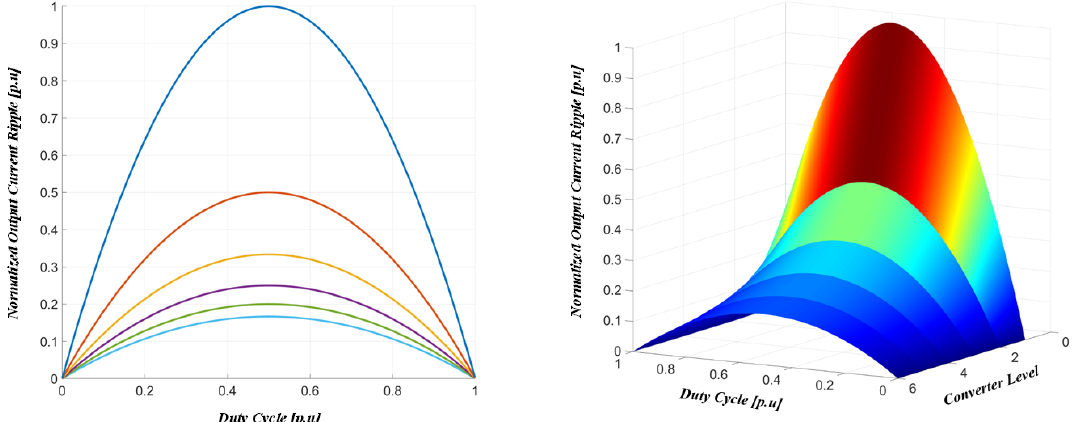
Figure 6. Normalized input ripple current versus duty cycle.